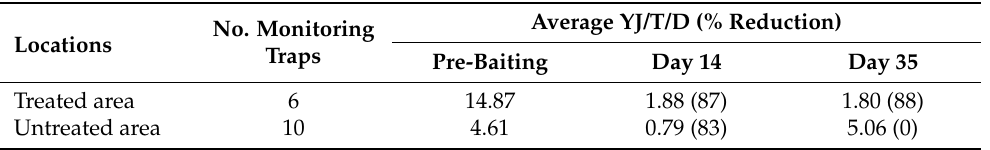
Table 3. The average number of yellowjackets trapped per trap per day (YJ/T/D) and percent reduction after baiting with 0.045% fluralaner in minced chicken at the San Diego Zoo Safari Park a . Average YJ/T/D (% No. Monitoring Locations Traps